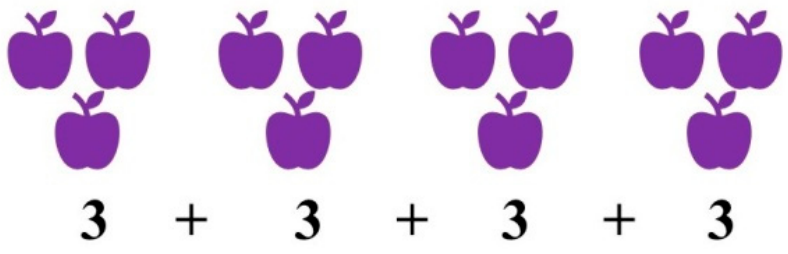
Figure 1. RAM of multiplication 4 × Figure 1 . RAM of multiplication 4 × 3 .